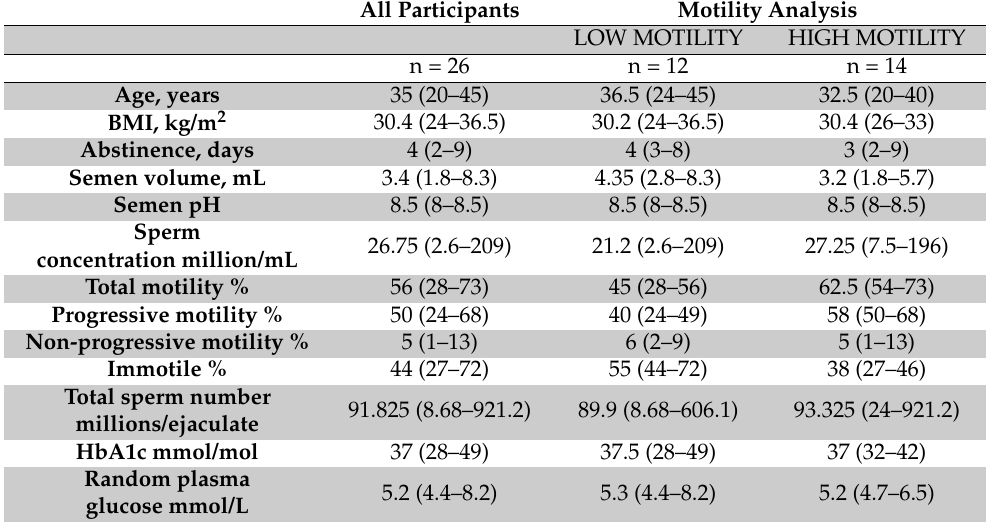
Table 1. Characteristics of participants included in this study. Men were categorised into groups according to progressive motility (< or ≥ median; 50% progressive motility). Data are presented as median (range). NB: WHO reference criteria for progressive motility: 32–75%. All Participants Motility Analysis LOW